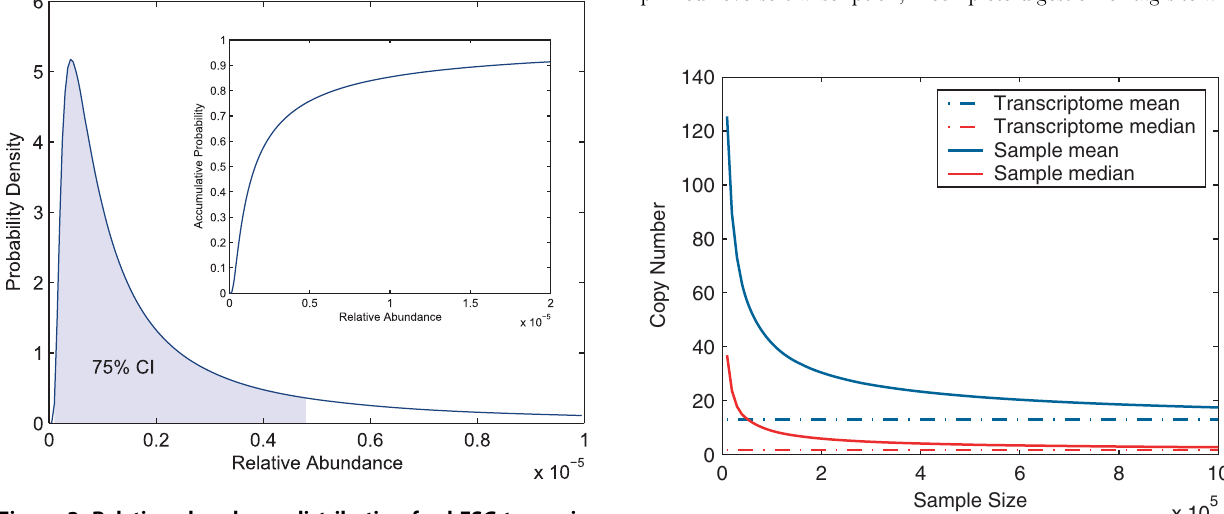
Figure 3. Relative abundance distribution for hESC transcrip- tome. The GIGP mixture is fitted with the pooled library that represents the hESC transcriptome. The probability density of the fitted generalized inverse Gaussian distribution is plotted (mode: 4.11e-7, mean: 1.30e-5, and median: 1.65e-6). The 75% confidence interval (CI) with minimum length is at [1.00e-7, 4.80e-6]. It is highly skewed toward zero and has a long tail. Inset: the distribution function of RAD, showing that 90% of the transcripts have relative abundances less than 1.66e-5.